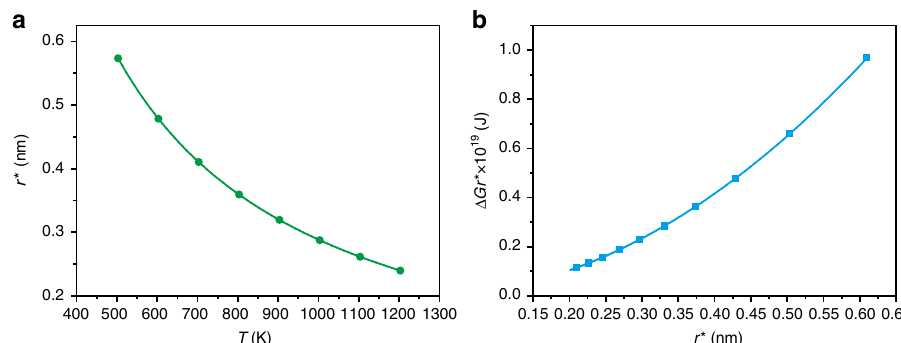
Fig. 6 The quantitative analysis of nucleation process. a The critical radius of nuclei ( r* ) as functions of nucleation temperature ( T ). b The critical excess free energy ( Δ G r* ) as functions of critical radius (